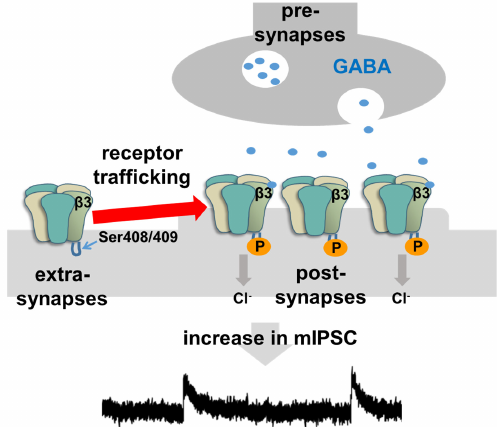
Figure 2. Schematic image of GABA A receptor trafficking mechanisms. The phosphorylation in the β 3 subunit Ser 408–409 increased levels of GABA A receptors at post-synapses, resulting an increase in mIPSC. Since IA training facilitated the phosphorylation in the β 3 subunit (Ser 408–409 ) and GABA A receptor-mediated current within 1 min, we suggested that the rapid inhibitory plasticity may contribute to maintaining memory function in hippocampus.